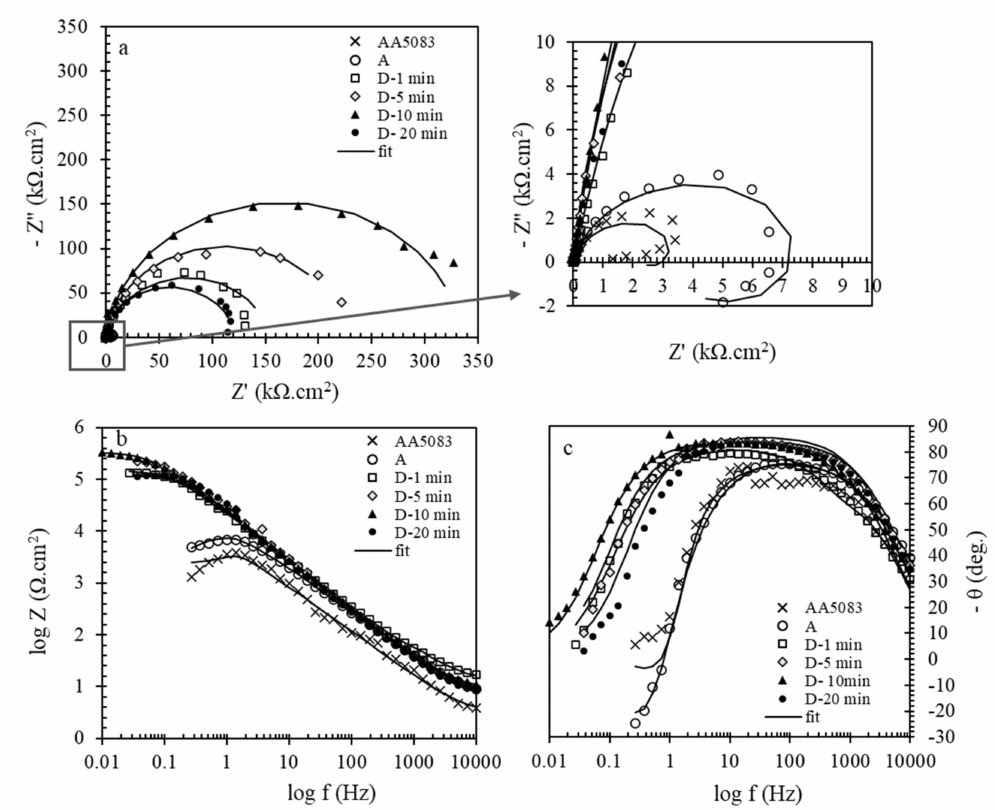
Figure 9. Typical ( a ) Nyquist, ( b ) Bode and ( c ) phase plots of coated and uncoated AA5083 samples in 3.5 wt.% NaCl corrosive media. The samples were prepared by the D Pretreatment Method with different deposition times (1, 5, 10, and 20